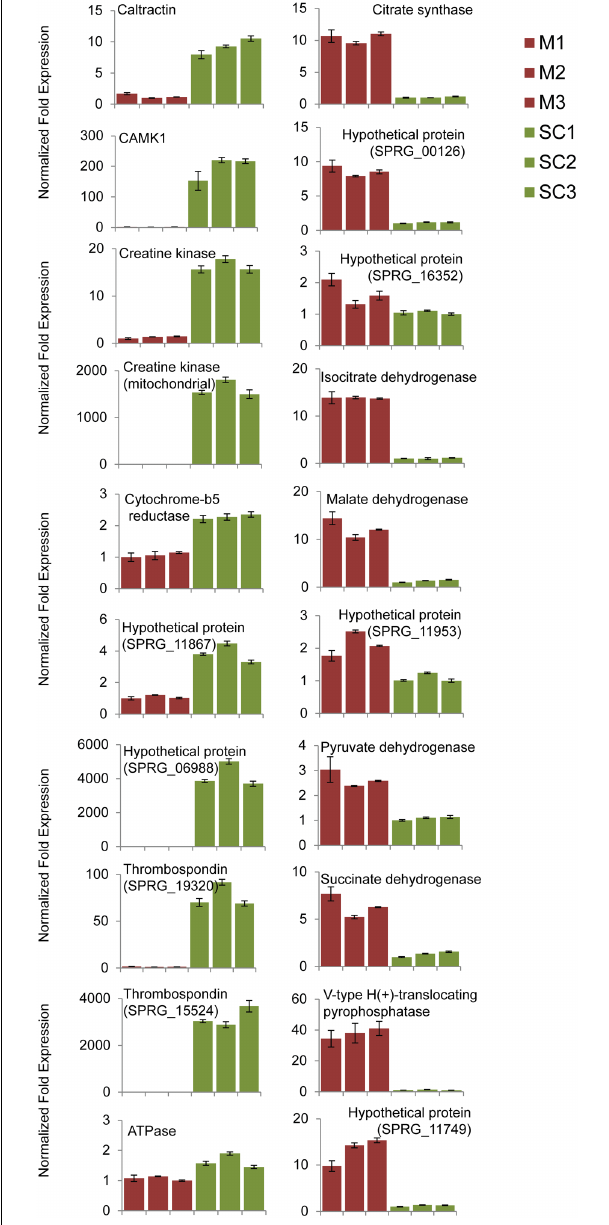
FIGURE 5 | Relative transcript abundance in the mycelium (M) and secondary cysts (SC) of S. parasitica . Gene expression was analyzed using quantitative RT-PCR. Relative expression levels were calculated by normalizing the data to the geometric mean of tubulin (SPRG_10729) and elongation factor (SPRG_10439). The vertical bars represent the standard errors of the mean normalized expression value for three separate biological replicates. Description and the corresponding accession number for each gene are shown in Supplementary Table S1.